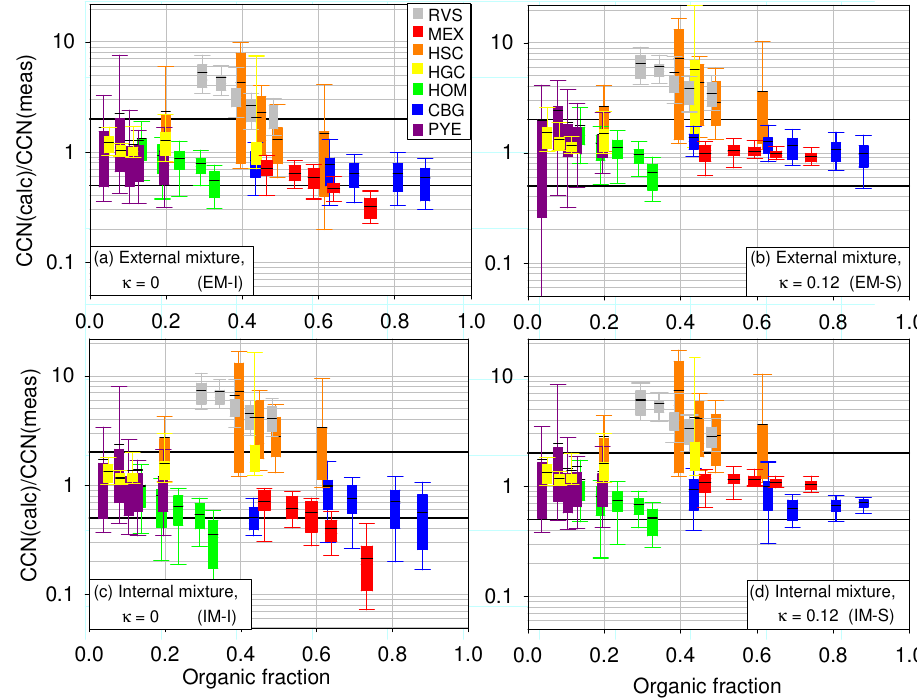
Fig. 3. Ratio of calculated to measured CCN number concentrations as a function of organic mass fraction for seven different data sets and different assumptions of hygroscopicity and mixing state of the organic fraction. Each bar represents 20% of the respective data set, error bars show ± one standard deviation; mean value is marked in each bar. Horizontal black lines represent CCN (calculated)/CCN (measured) = 0.5 and 2,